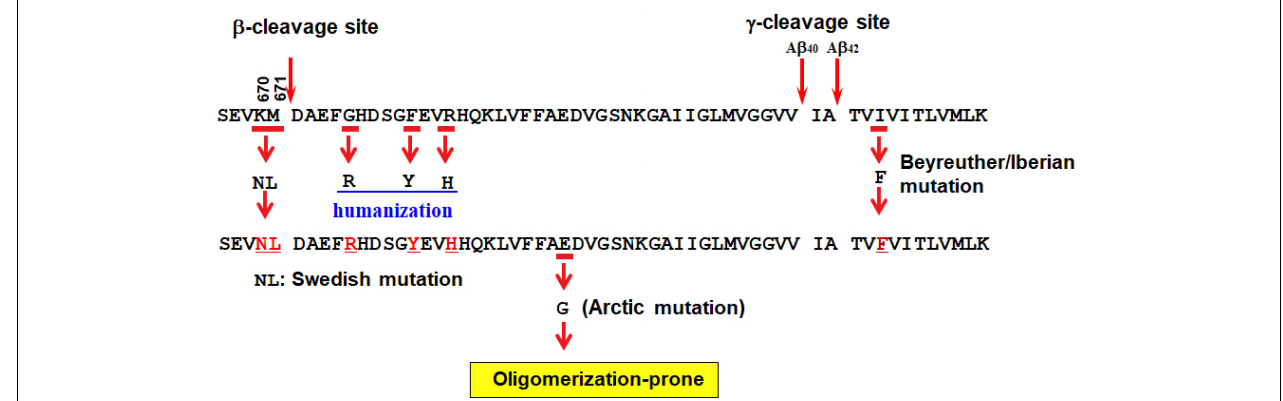
FIGURE 2 | Second generation mouse models of Alzheimer’s disease. See text for detailed explanation.